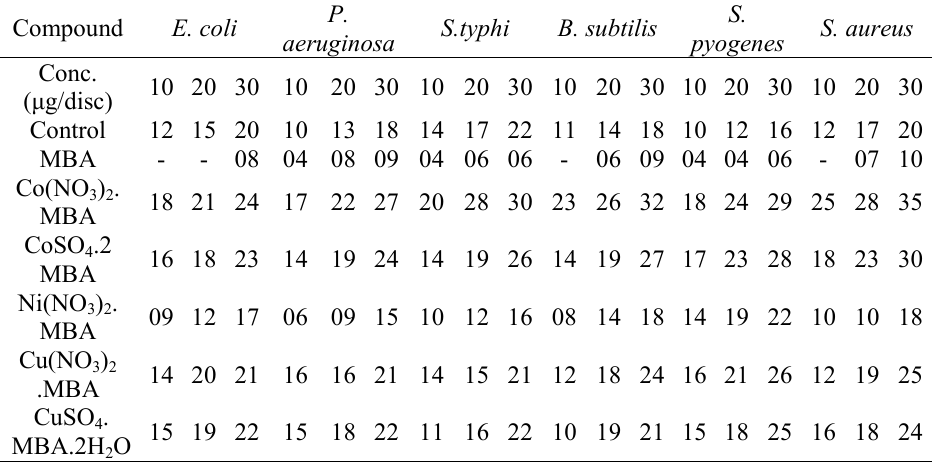
Table 3. Antibacterial activity of ligand and its complexes.